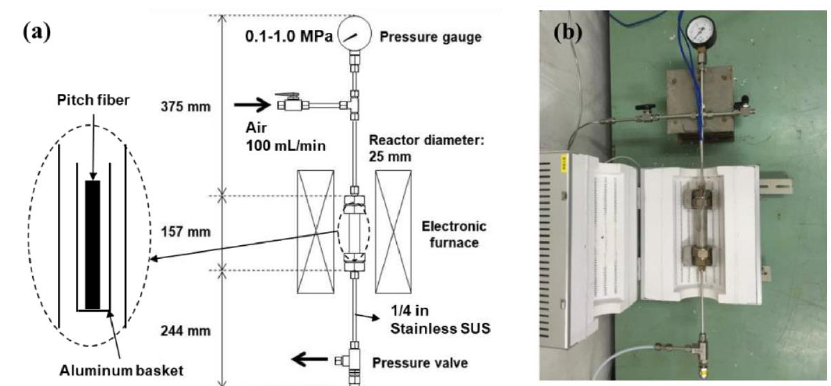
Figure 2. The schematic and real pictures of self-designed laboratory-type oxidative stabilization apparatus: ( a ) schematic picture of self-designed laboratory-type oxidative stabilization apparatus and ( b ) real picture of self-designed laboratory-type oxidative stabilization apparatus.